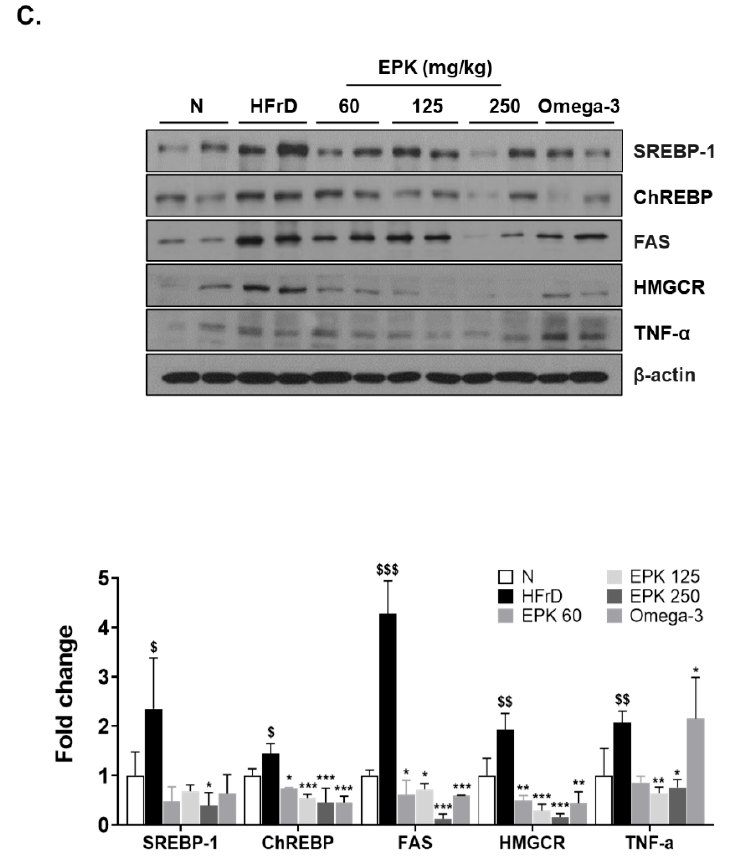
Figure 2. Effect of EPK on SREBP-1 and FAS in HFrD rats ( A ) The liver pathology ( B ) Analysis of SREBP-1 mRNA level in liver tissue. Values were indicated as mean ± SD in each group. * p < 0.05 and ** p < 0.01 versus the HFrD control group. $ p < 0.05 versus normal group. ( C ) SREBP-1, ChREBP, FAS, HMGCR, and TNF α protein expression in liver tissue. Quantitative protein levels are shown in the bar graph as mean ± SD. * p < 0.05, ** p < 0.01, and *** p < 0.001 versus HFrD control group. $ p